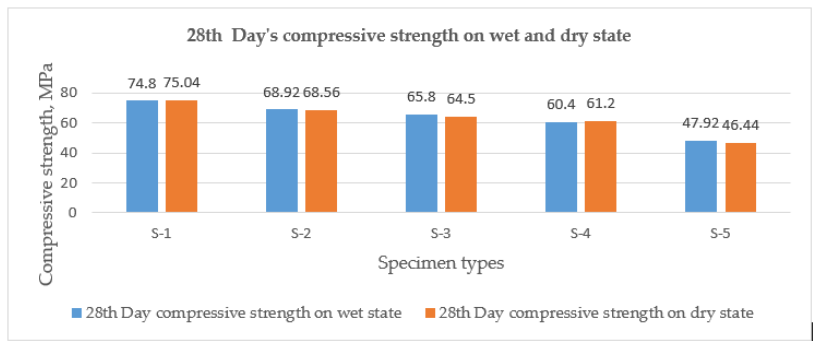
Figure 5. 28th day Compressive strength of concrete samples on wet and dry state.